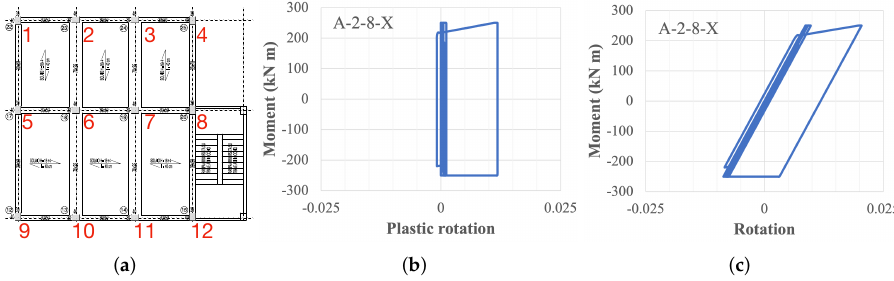
Figure 11. ( a ) Column numbers of building A. ( b ) Column 2, second inter-storey, X-direction rotation, moment-plastic rotation diagram. ( c ) Moment-total rotation diagram. Table 6. Numerical response quantities of the columns of building A based on the experimental results. ID is composed by three symbols: building, inter-storey (see the caption of Table 5 for the corresponding numbering), and column (ref. Figure 11a). θ y , θ u and θ max are the chord rotations (in %), respectively, at yielding, ultimate and maximum attained during the earthquake; D l is the local damage parameter from Equarion (4). An asterisk is reported where the elastic range is not